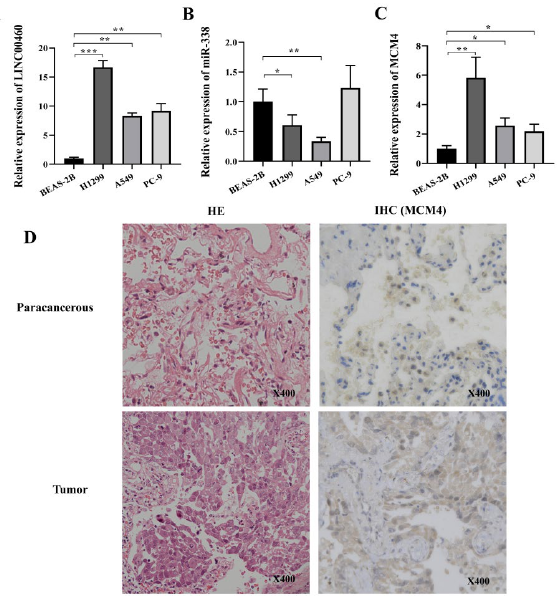
Figure 6. Differential gene expression levels were verified by RT-PCR and IHC (MCM4). The expression level of LINC00460 ( A ), miR-338 ( B ), MCM4 ( C ) in BEAS-2B, A549, PC-9 and H1299 cells was detected by RT-PCR. ( D ) Tumor and paracancerous tissue sections were subjected to H&E staining and IHC against MCM4. Statistically significant differences between the two groups of data were estimated by independent t-test. * p < 0.05, ** p < 0.01, *** p < 0.001. p < 0.05 was considered statistically significant.